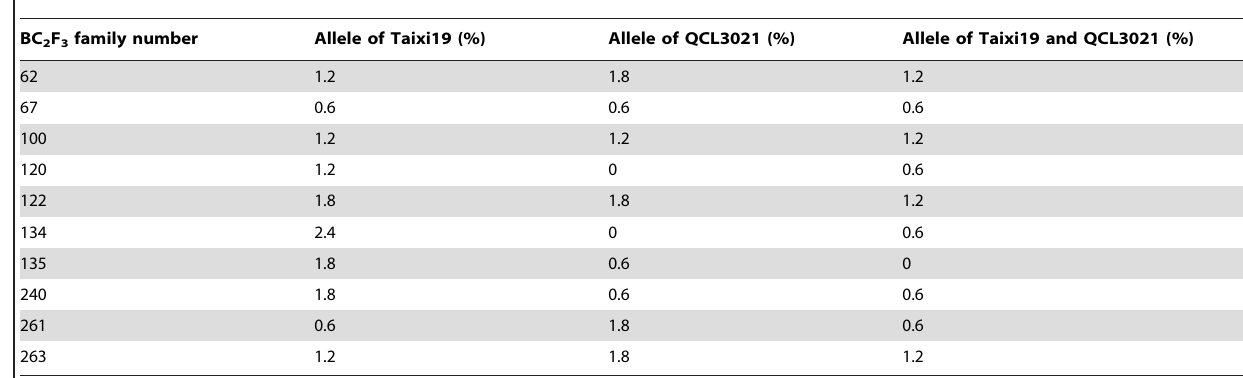
Table 5. Proportion of donor parent allele of 10 selected families in BC 2 F 3 .